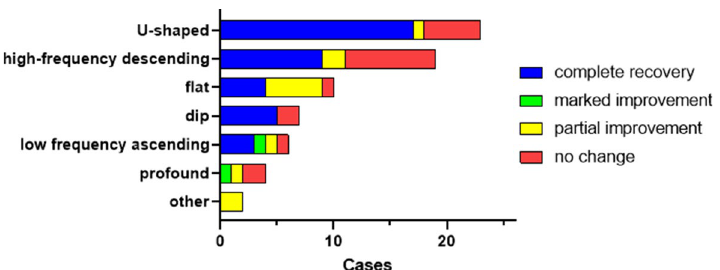
Figure 4. Frequency distribution of audiogram forms in the first sudden sensorineural hearing loss episode, stratified by degree of recovery. Audiogram shape was significantly related to recovery rate ( P = 0.048). Residual analysis based on the results of Chi-squared test revealed recovery of hearing in patients having U-shaped audiograms was significantly greater than in patients having the other audiogram forms ( P < 0.05) and the amount of recovery for the profound form was significantly less than that of the other audiogram forms ( P < 0.05). This bar chart was created using GraphPad Prism 9.0.0 for Windows, GraphPad Software, San Diego, California USA, www. graph pad.